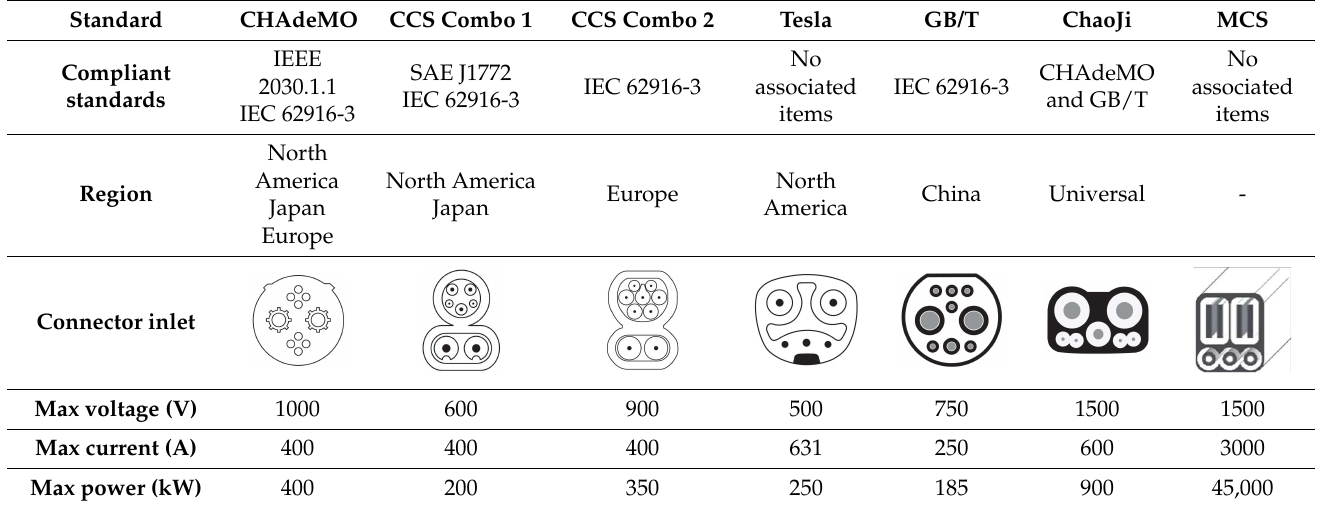
Table 1. Standards for ultra-fast charging systems.